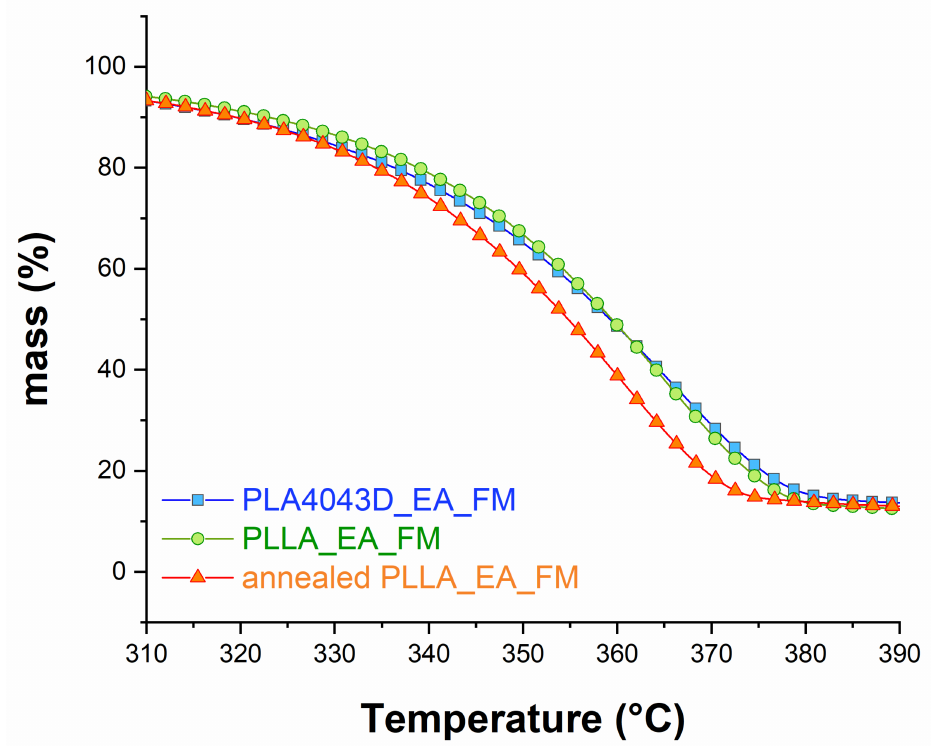
Figure 3. TGA curves of the biocomposites before